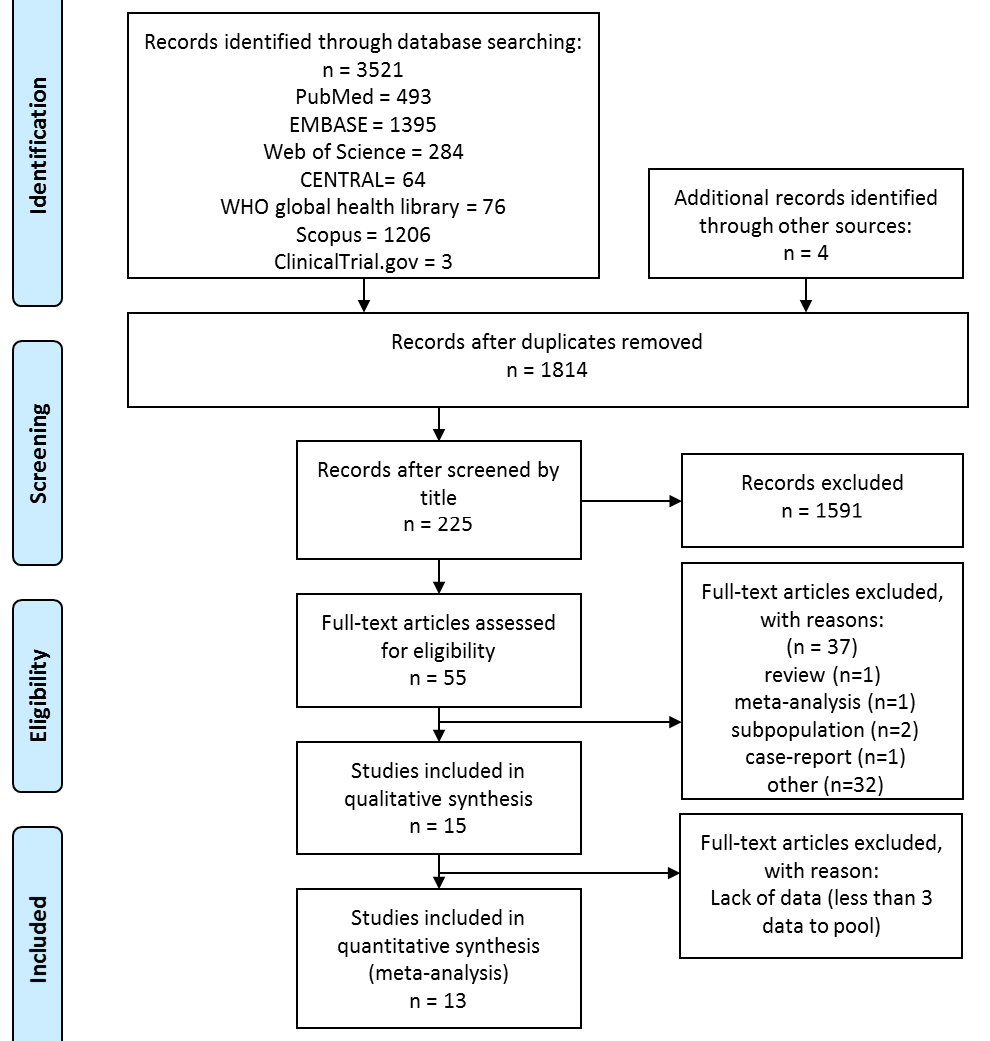
Figure 1. Preferred Reporting Items for Systematic Reviews and Meta-Analysis (PRISMA) flowchart for the study selection procedure.